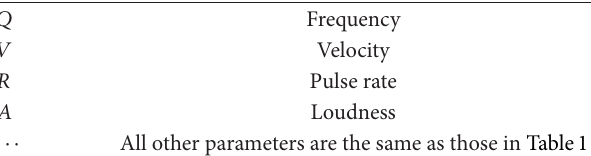
Table 3: Parameters used for